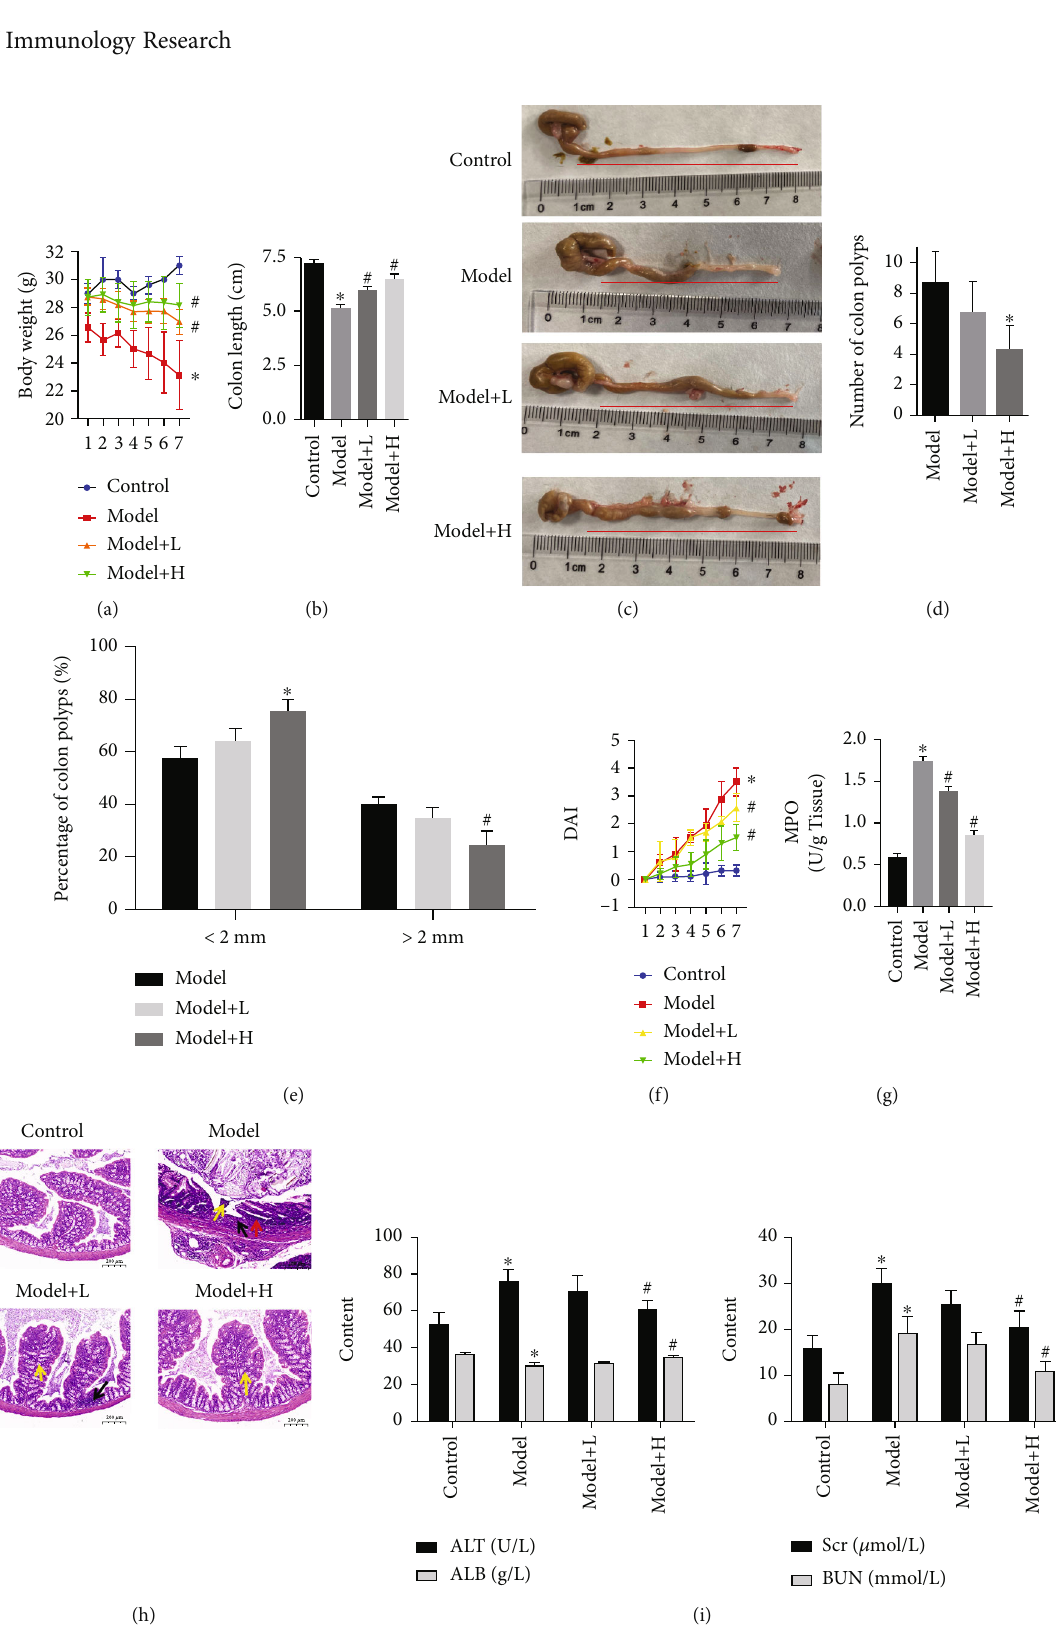
Figure 2: E ff ect of Qinghua Jianpi Recipe on intestinal in fl ammation, tumorigenesis, and pathological changes. (a) Body weight change in mice in seven weeks; (b, c) colon length of mice in each group and statistical results; (d) the number of intestinal tumor formation in adenoma model mice; (e) the size of intestinal tumor formation in adenoma model mice ( < 2 mm or > 2mm); (f) DAI score of rats in each group; (g) levels of MPO of intestinal tissues in each group; (h) HE staining of intestinal tissues. (i) Liver and kidney function indexes were analyzed in each group. ∗ P < 0 : 05 and # P < 0 : 05 , the di ff erence was statistically signi fi